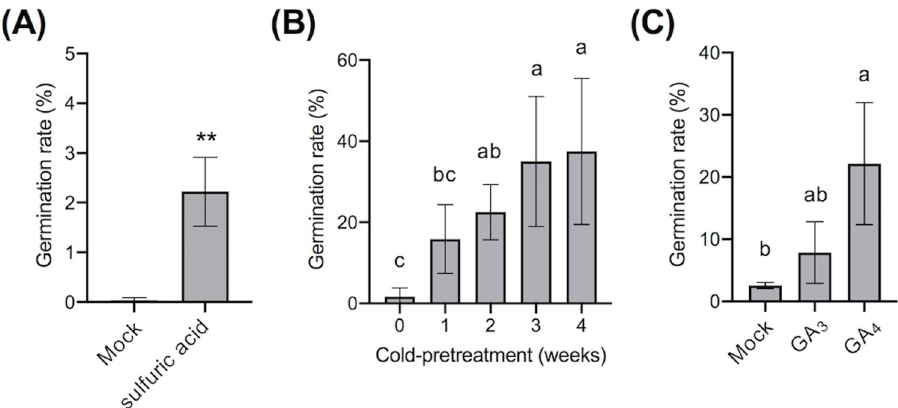
Fig 2. Effect of gibberellic acid and cold pretreatment on the germination of Toxicodendron vernicifluum seeds. (A) Germination-promoting effect of sulfuric acid on T . vernicifluum seeds. The germination rate represents the average of three independent experiments ( n = 3). The control was treatment with water (Mock). (B) Cold pretreatment promotes germination in T . vernicifluum seeds. Before incubation at 20˚C, the seeds were exposed to cold temperature (4˚C) for 0–4 weeks. Cold-treated seeds were incubated at 20˚C, and germinated seeds were counted 60 days after the start of incubation. The germination rate represents the average of nine independent experiments ( n = 9). (C) Germination-promoting effects of GA 3 and GA 4 . The control was treatment with 0.15% DMSO (Mock). The germination rate represents the average of three independent experiments ( n = 3). Significant differences ( �� P < 0.01) were determined by with an unpaired t -test with Welch’s correction (A). Datasets were analyzed using the Kruskal–Wallis test with post-hoc Dunn’s multiple comparisons test (B) or one-way ANOVA with Tukey’s multiple comparisons test (C) with a significance level of 5% ( P <